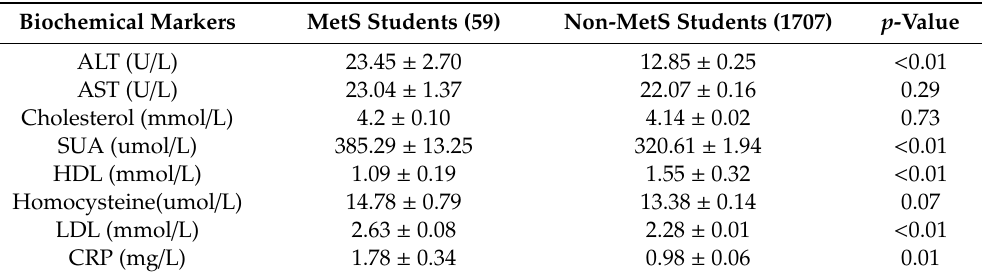
Table 3. Concentrations of biochemical markers in non-MetS and MetS students. Biochemical Markers